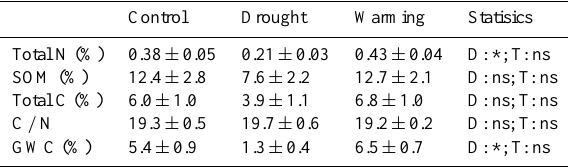
Table 1. Soil properties: total soil nitrogen (N) and carbon (C), soil organic matter (SOM) and gravimetric soil water content (GWC) in percentage of dry weight (%). Significant effect ( P < 0.05) of treat- ment is indicated by an asterisk (*), whereas ns is non-significant.